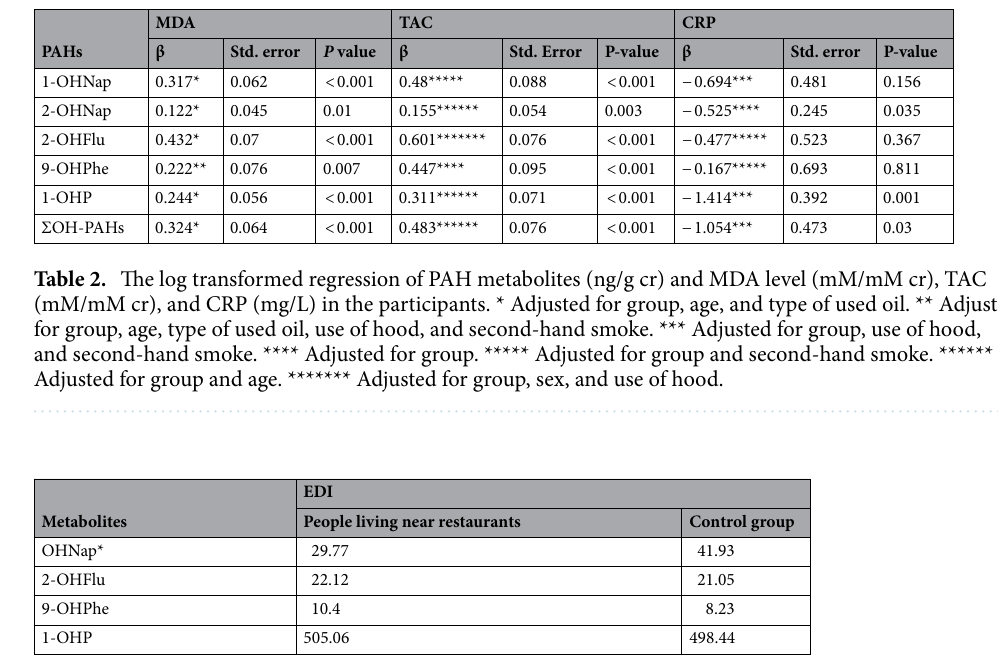
Table 3. EDIs for OHNaps, 2-OHFlu, 9-OHPhe, and 1-OHP among the people living near restaurants and control group participants. Sum of 1-OHNap and 2-OHNap.